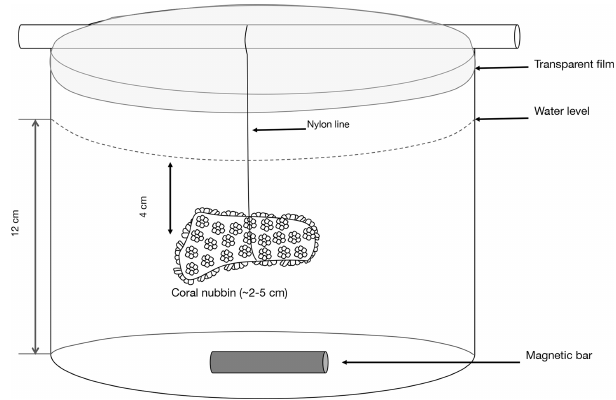
Figure 1. Scheme of the polyethylene container in which a coral nubbin is suspended with a nylon line and covered with a transpar- ent